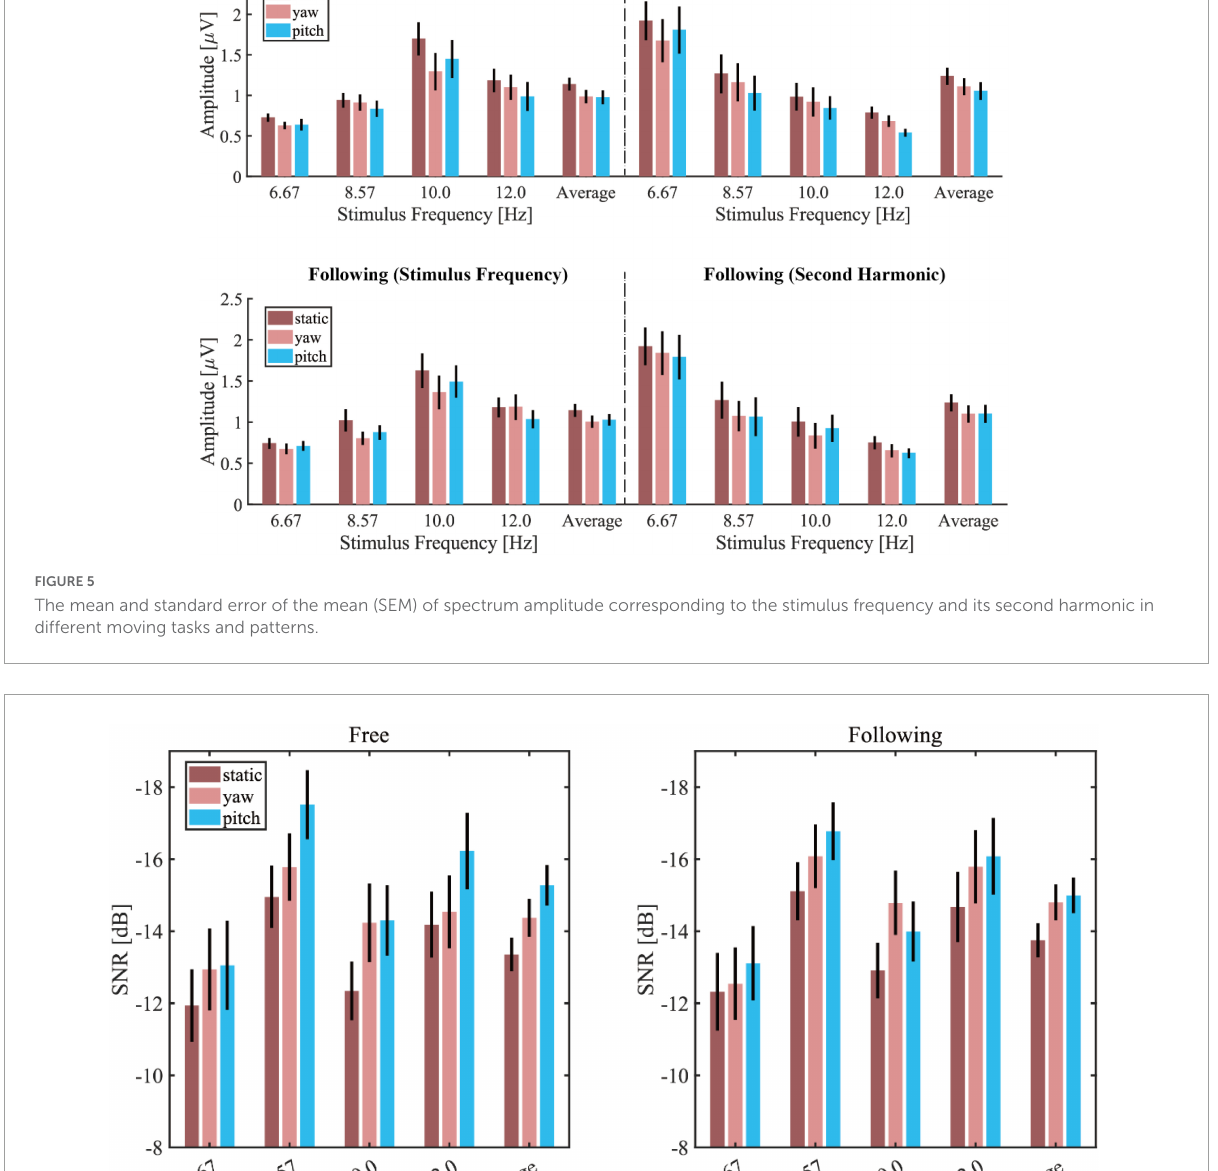
it was possible to gaze at the stimulus and observe the environment